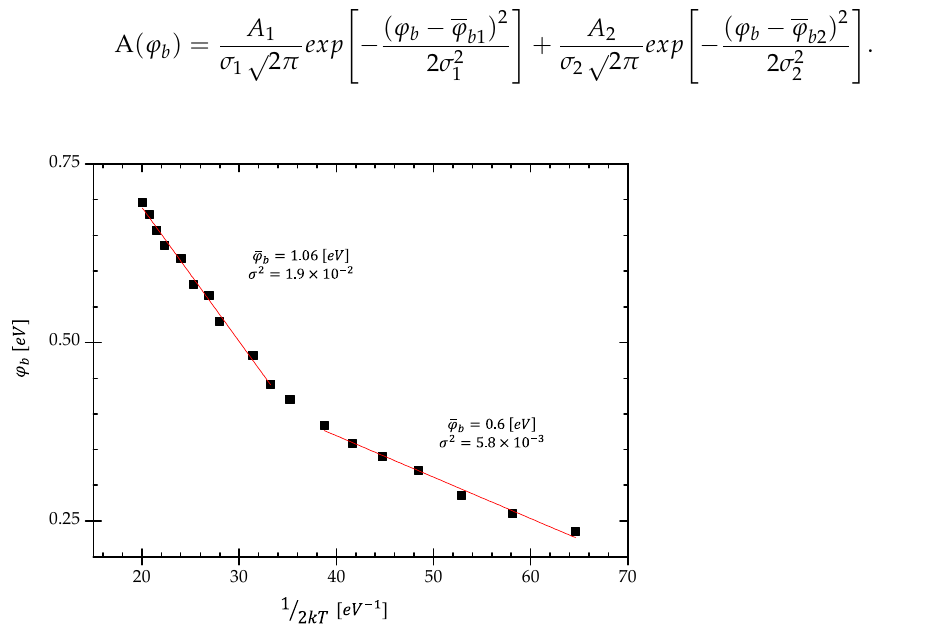
Figure 6. The variation of the barrier height ϕ b as a function of (1/2 kT) according to the Werner model.